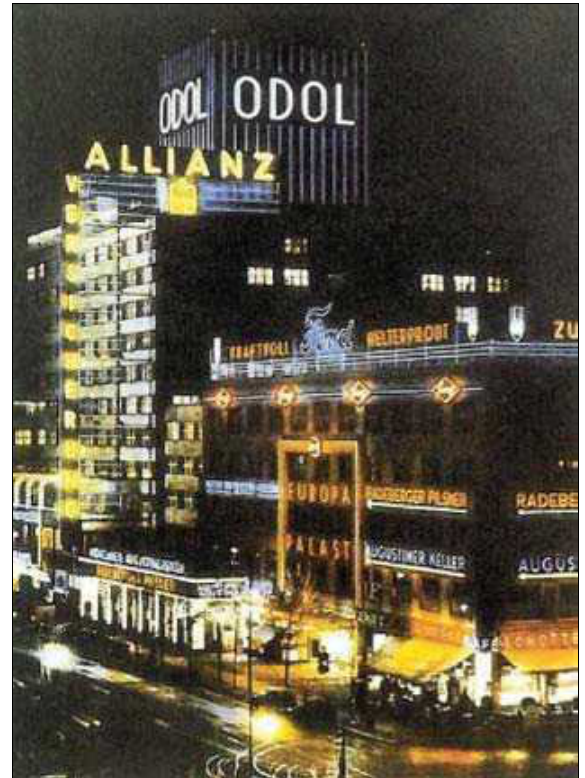
Fig. 11. “berliner europhaus” shopping centre, 1936